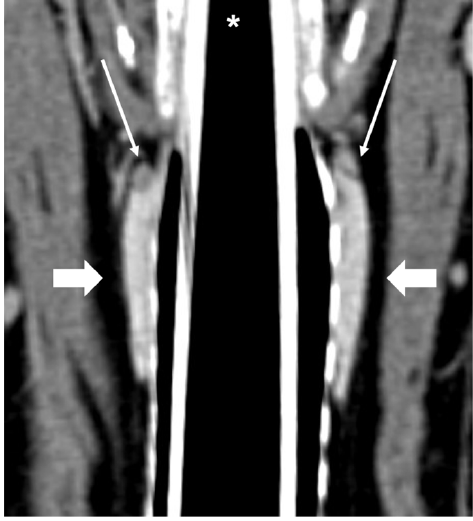
Figure 2. CT appearance of normal external parathyroid glands. Post-contrast dorsal CT reconstruc- tion showing external parathyroid glands (thin arrows), visible at the cranial part of both thyroid lobes (large arrows); the left and right thyroid lobes and respective external parathyroid glands are all visible in this single image. * Trachea with endotracheal